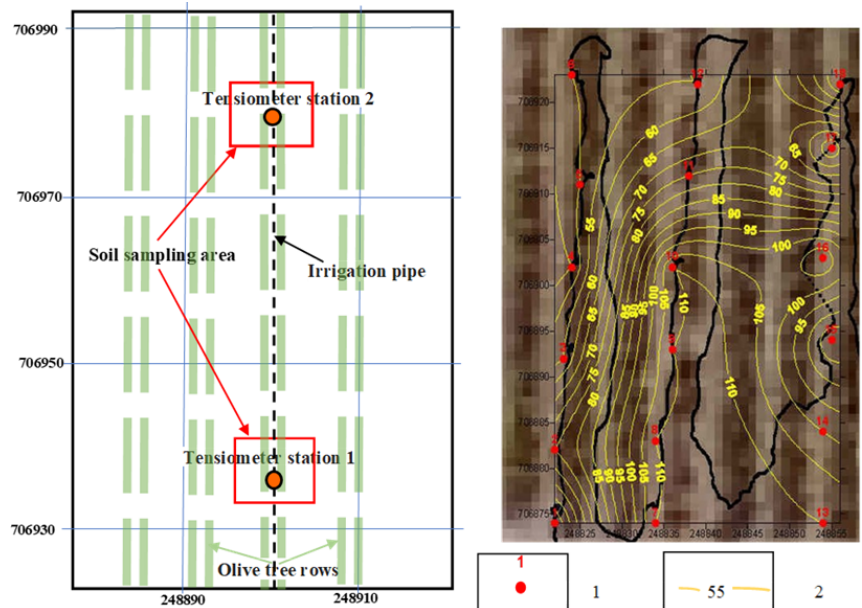
Figure 3. Depth of the travertine layer from the soil surface in centimeters (background aerial photo is an insert from Fig. 1; orthophoto). 1 – lithological borehole; 2 – isoline of travertine layer depth from the soil